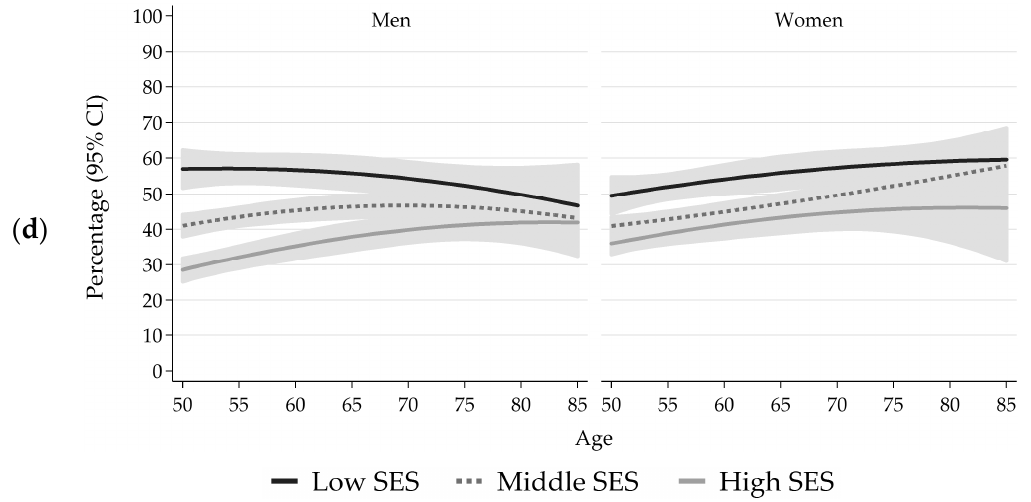
Figure 1. Model-adjusted prevalence with 95% confidence intervals (CI) of less-than-good self-rated health ( a ), global activity limitations ( b ), walking limitations ( c ), and low back complaints ( d ), by socioeconomic status (SES) and age, adjusted for residential region, urban/rural, and immigrant status.